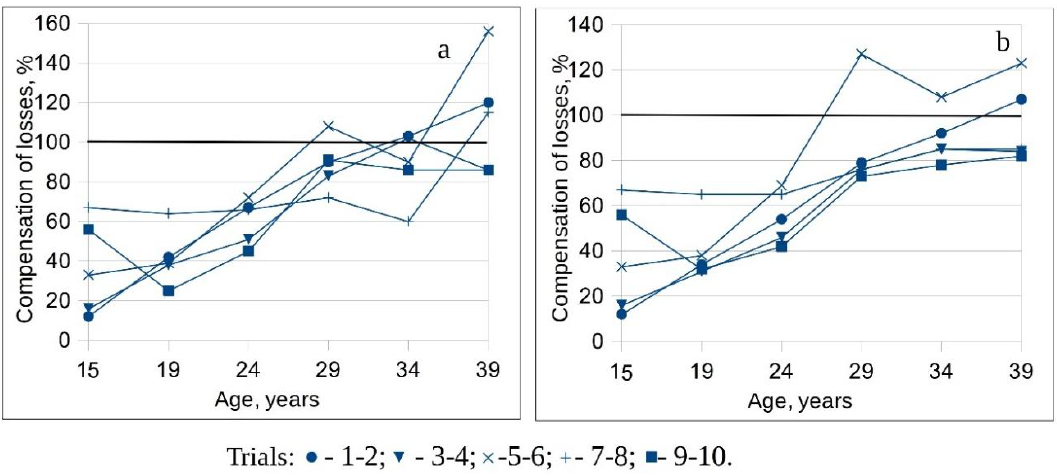
Figure 5. Changes of level compensation of gross increment ( a ) and accumulated in stand growing stock volume losses ( b ) due to more intensive growth of trees in rows neighboring to strip road of 3.5 m width depending on age and growing density (trials).